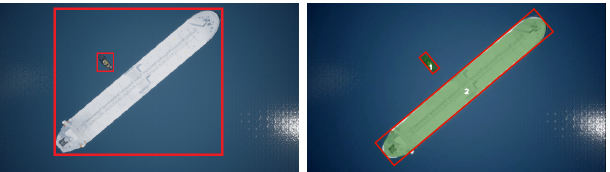
Figure 5. ( left ) Worst case scenario with axis-aligned bounding boxes. The bounding box of the small ship is inside the bounding box of the large ship. ( right ) Segmentation mask superimposed on top of the two ships. A rotated bounding box is made based on segmentation, thus representing the vessel’s spatial location more